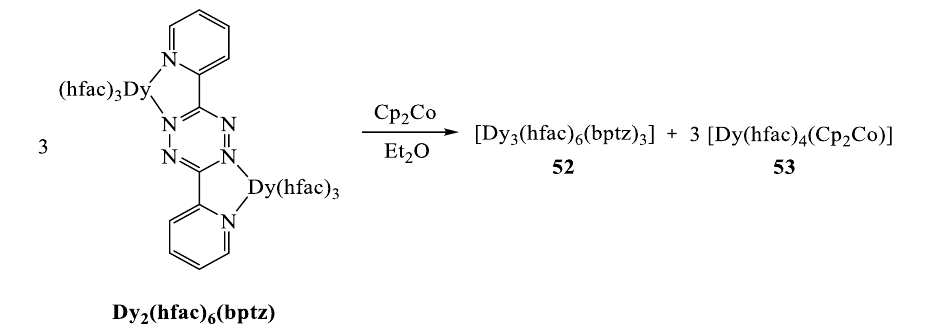
are transparent for clarity. The cif has been retrieved from CCDC. CCDC number is 1811780.